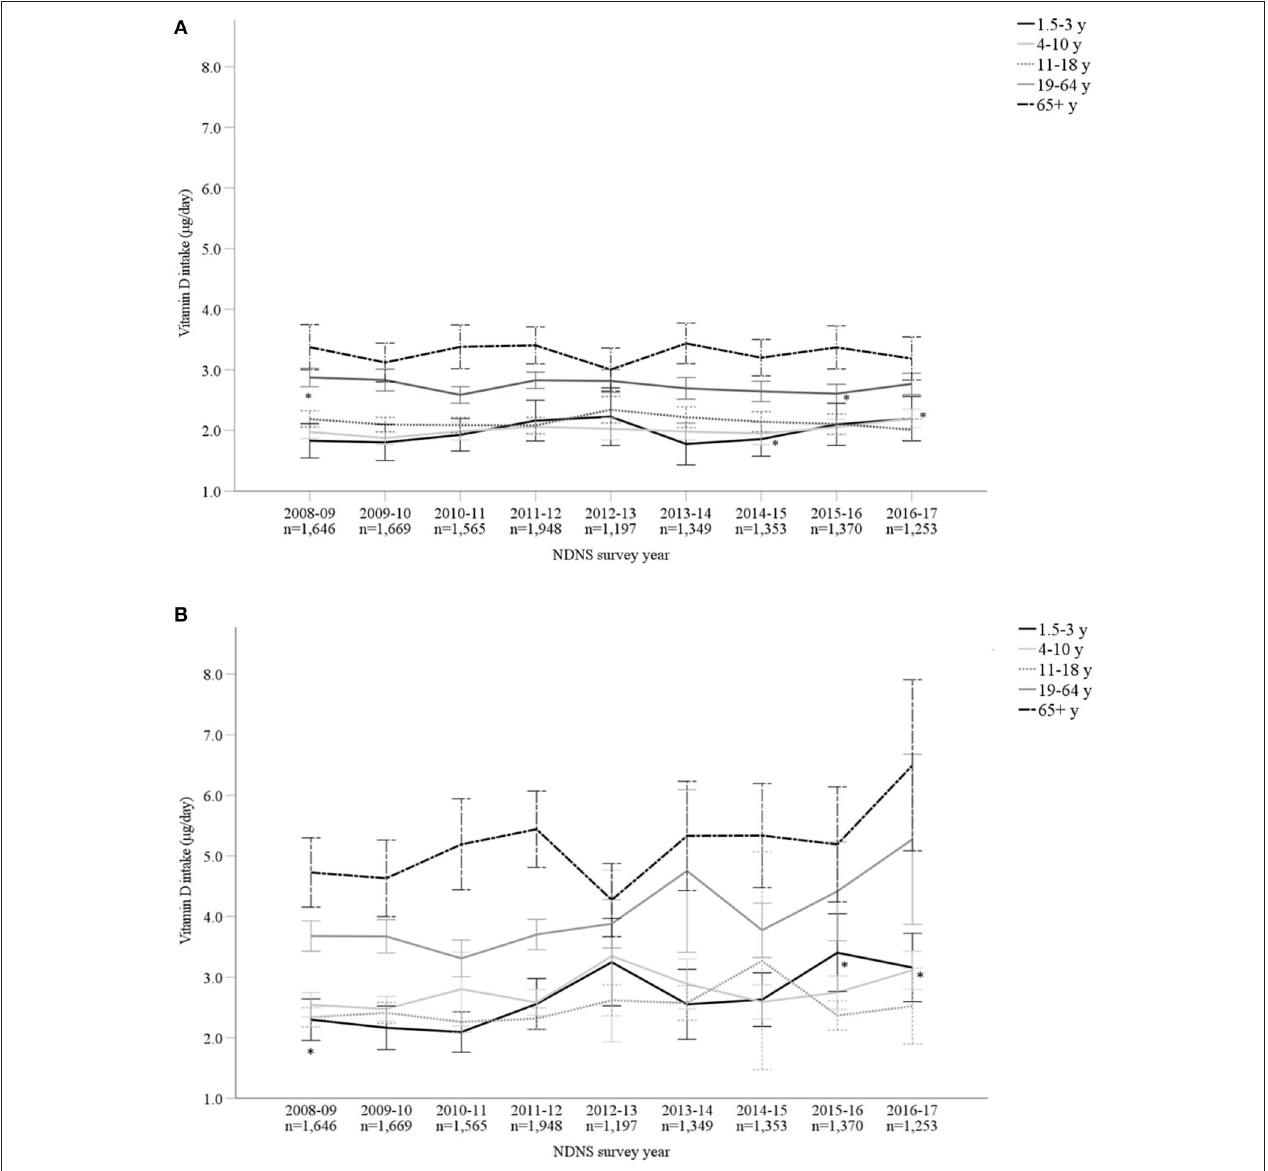
FIGURE 2 | (A,B) Vitamin D intake ( µ g/day) from diet alone (A) and in combination with supplements (B) , split by age categories, from Years 1–9 (2008–2017) of the UK National Diet and Nutrition Survey (NDNS; total n = 13,350). Data is presented as mean (95% CI). *Denotes significant difference ( p < 0.05) between survey years within age group; one-way ANOVA tests using log transformed data. For post-hoc (Tukey) tests between ages groups in the same survey year, see Supplementary Material . UK, United Kingdom; n , number of participants; y, years; CI, confidence